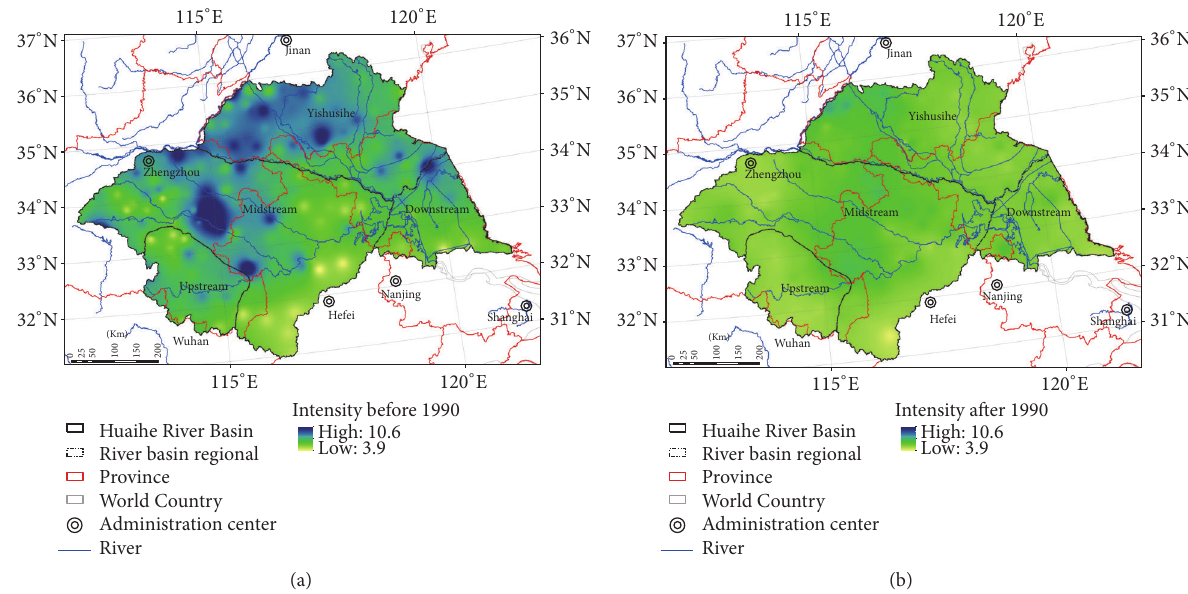
3.9Intensity High: 10.6 Low: